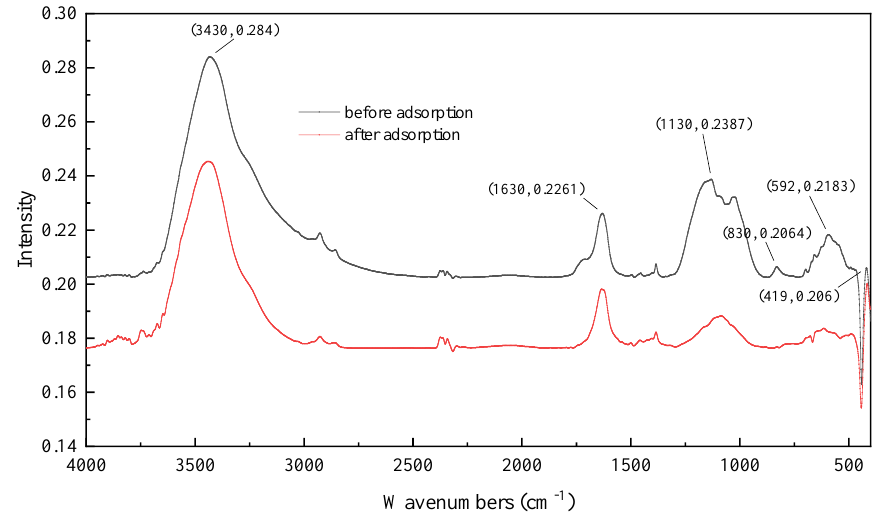
Figure 8. FT-IR spectrum of pyrite before and after thiourea adsorption.